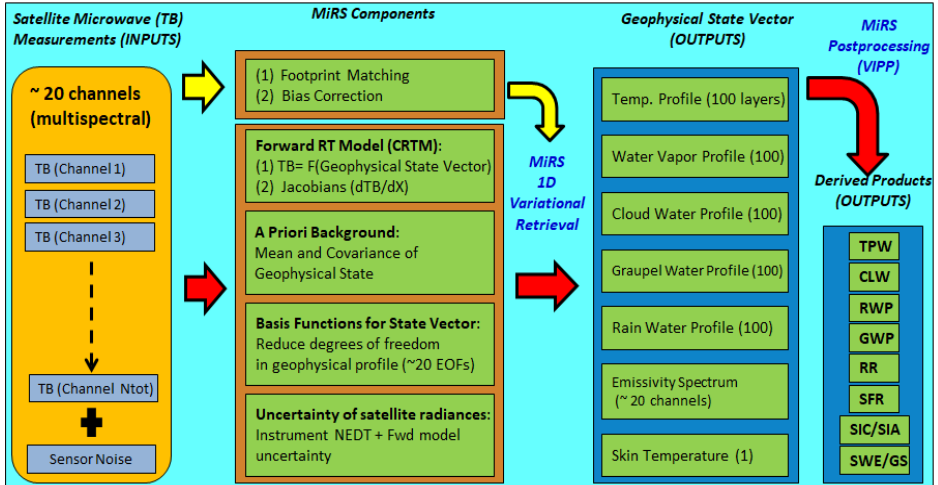
Figure 1. Schematic of MiRS processing components and data flow showing MiRS core retrieval and post-processing components. Core products are retrieved simultaneously as part of the state vector. Post-processing products are derived through vertical integration (water vapor, hydrometeors), catalogs (SIC, SWE), or fast regressions (rain rate). Post-processed hydrometeor retrieval products are Rain Rate, Graupel Water Path, Rain Water Path and Cloud Liquid Water.